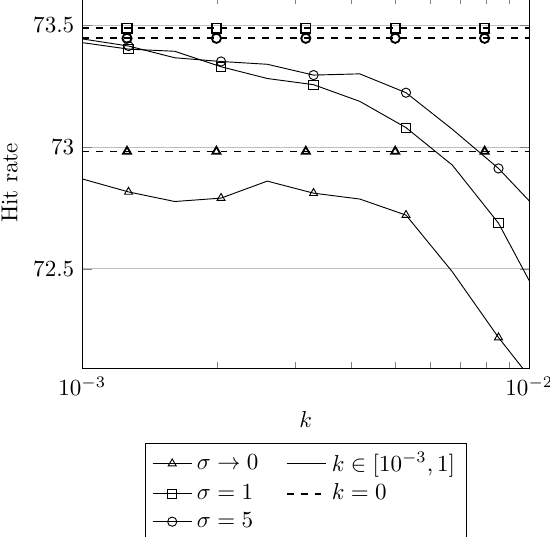
Figure 12. Resized version from Figure 11. We only plotted the IE method between k = 10 − 3 and k = 10 − 2 . We resized the hit rate axes as well. With these adjustments, it is possible to distinguish the small changes caused by changing the width of the Gaussian initial condition.